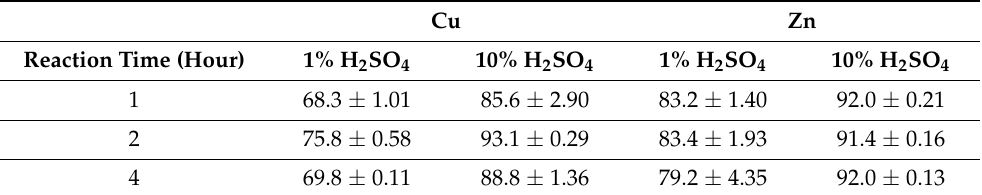
Table 4. The influence of addition of ultrasound process on removal efficiency of Cu and Zn from swine